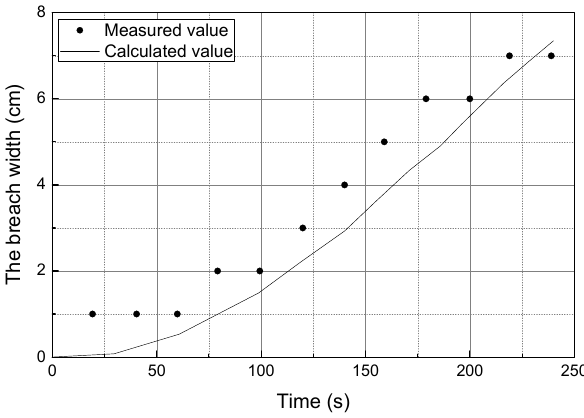
Figure 12. Comparison of the calculated and measured breach width for four reinforcement layers.